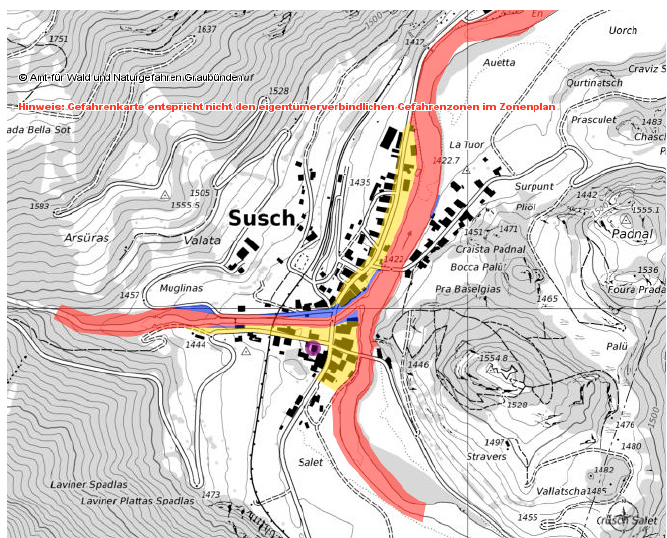
Figure 5. Natural hazard risk map of Susch: flood risk zones (Latitude: 46.750798 | Longitude: 10.079666; © Canton of Grisons) .